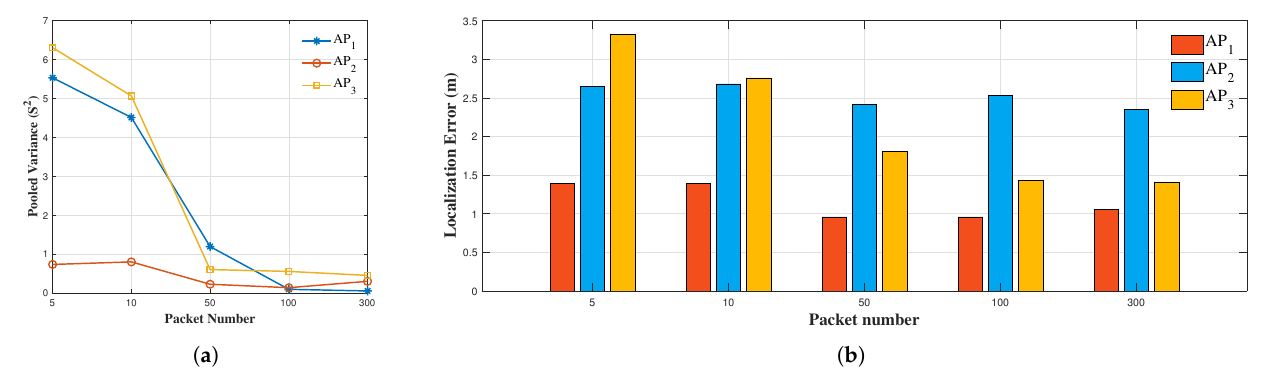
Figure 9. Impact of different input packet numbers on the results. ( a ) Pooled variance of the results with three APs; ( b ) localization error with three APs.